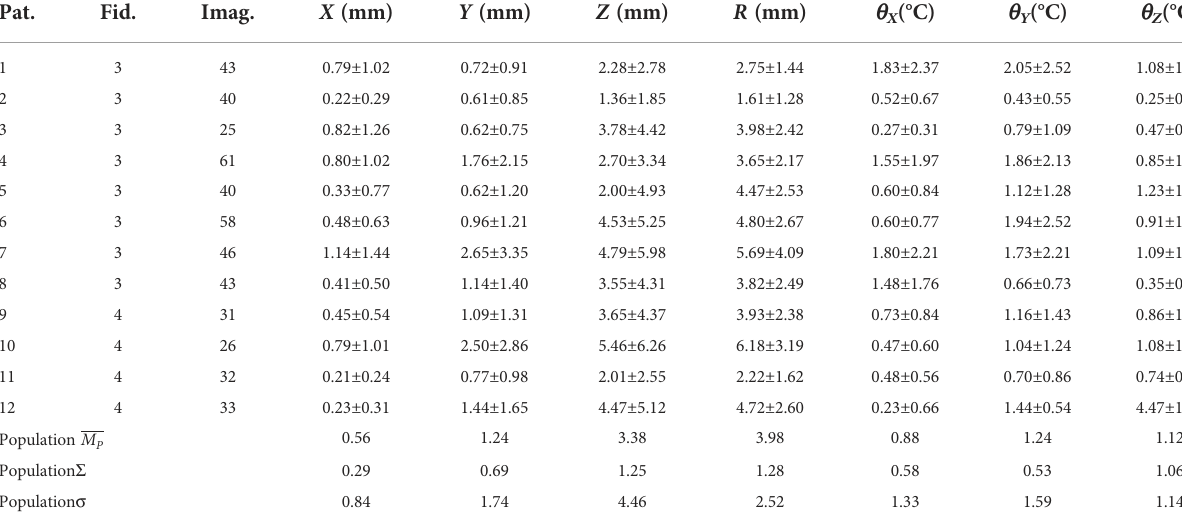
TABLE 2 Systematic and random errors of translation and rotation in different directions. Pat.